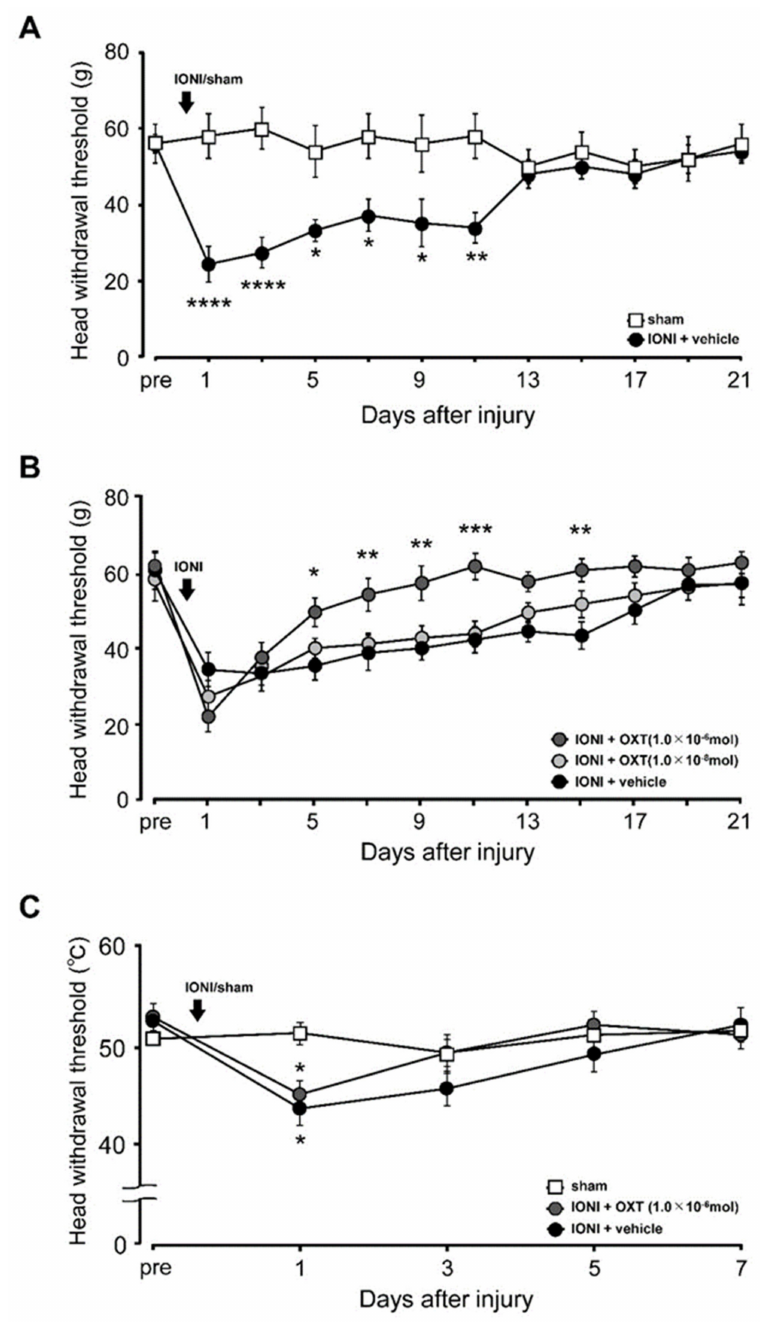
Figure 1. Changes in mechanical and heat sensitivities of the whisker pad skin after infraorbital nerve injury (IONI) or sham treatment. ( A ) The head withdrawal threshold for mechanical stimulation (MHWT) of the whisker pad skin after IONI or sham treatment ( n = 15 in each group). * p < 0.05, ** p < 0.01, **** p < 0.0001 (vs. the sham treatment group). ( B ) The MHWT of the whisker pad skin after IONI with vehicle or oxytocin (OXT) administration (IONI + OXT (1.0 × 10 − 6 mol), n = 10; IONI + OXT (1.0 × 10 − 8 mol), n = 9; IONI + vehicle, n = 9). * p < 0.05, ** p < 0.01, *** p < 0.001 (vs. the IONI treatment with vehicle group). ( C ) The heat head withdrawal threshold of the whisker pad skin after sham treatment or IONI with vehicle or OXT administration (sham, n = 5; IONI + OXT (1.0 × 10 − 6 mol), n = 10; IONI + vehicle, n = 10). * p < 0.05, (vs. the sham treatment